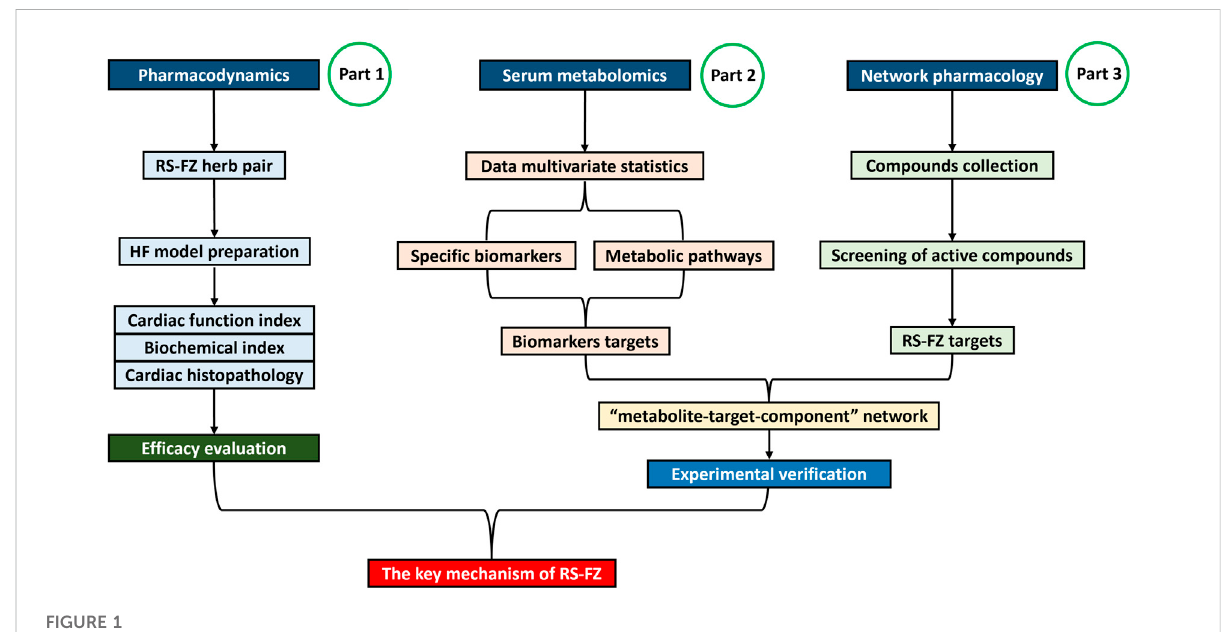
FIGURE 1 The detailed fl owchart of the study